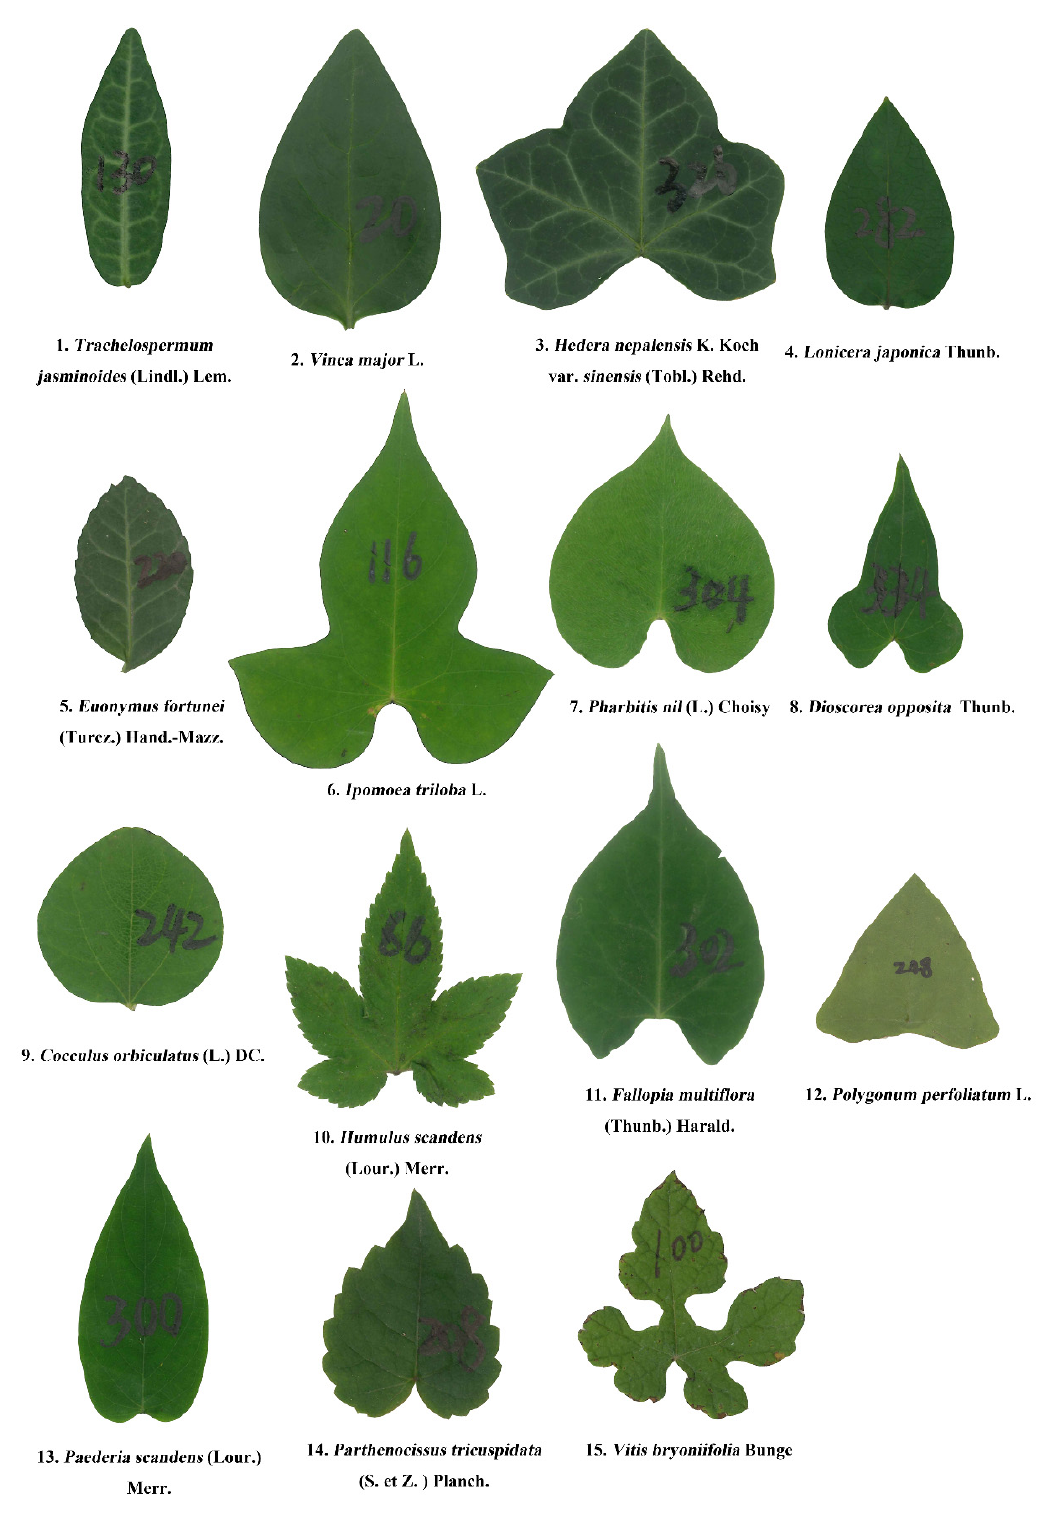
Figure 1. Representative leaf images of 15 species of climbing plants. Species 1 − 5, 9, 14, and 15 are woody vines, and the remaining seven species are herbaceous vines.